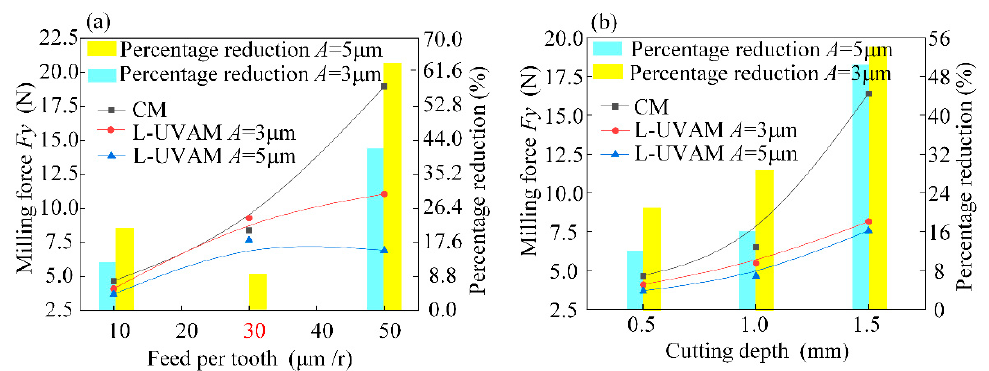
Figure 5. Single-factor analysis of Fx . ( a ) Effect of variation of feed per tooth on milling force Fx ; ( b ) Effect of cutting depth variation on milling force Fx .